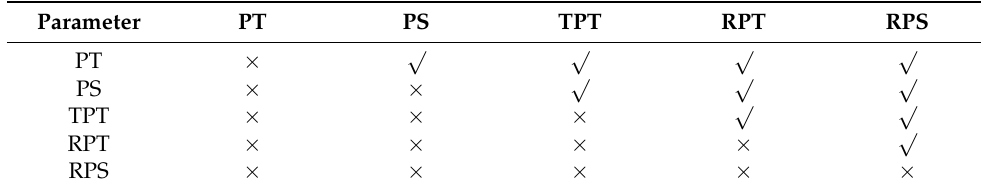
Table 6. Mixed parameter DR.